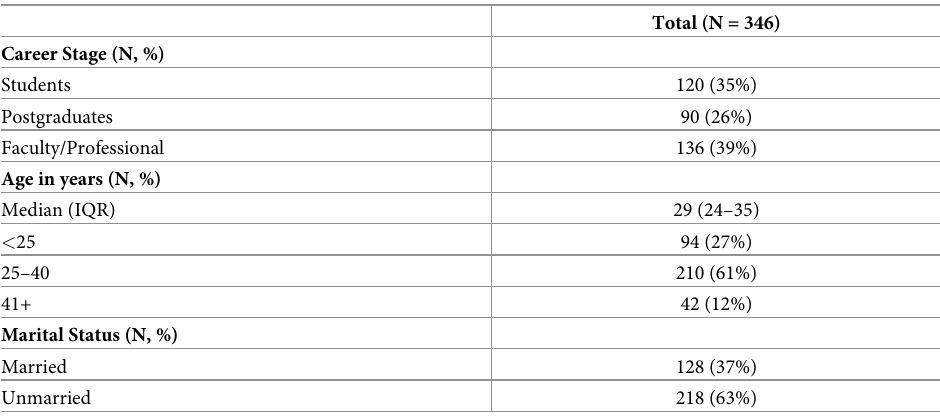
Table 1. Respondent characteristics �